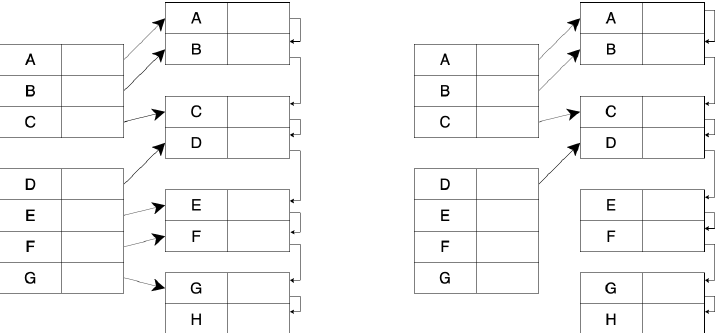
Figure 1. Dense vs Spare index. Dense indices are faster in general, but sparse indices require less space and impose less maintenance for insertions and deletions.